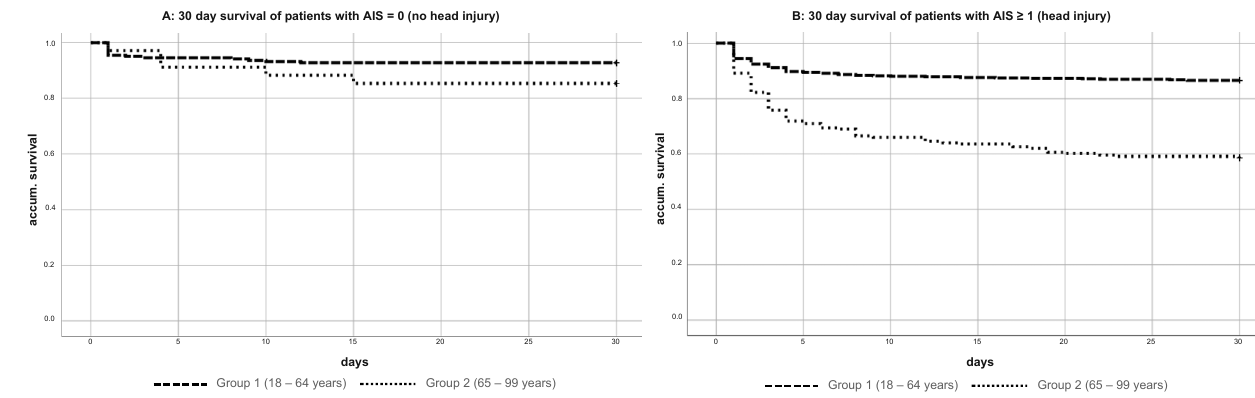
Figure 4. ( A , B ) Kaplan–Meier curve of 30-day survival severely injured patient (ISS ≥ 16) Group 1 vs. Group 2 with and without head injury AIS ≥ 1.